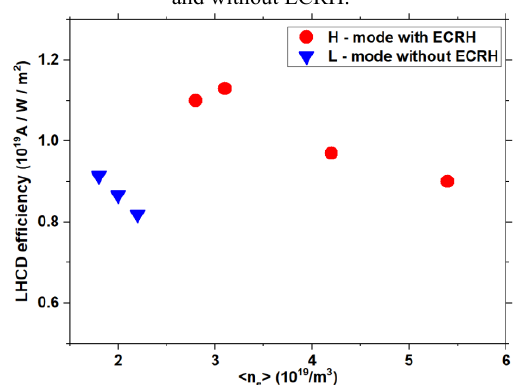
Fig. 11. Comparison of LHCD efficiency with and without